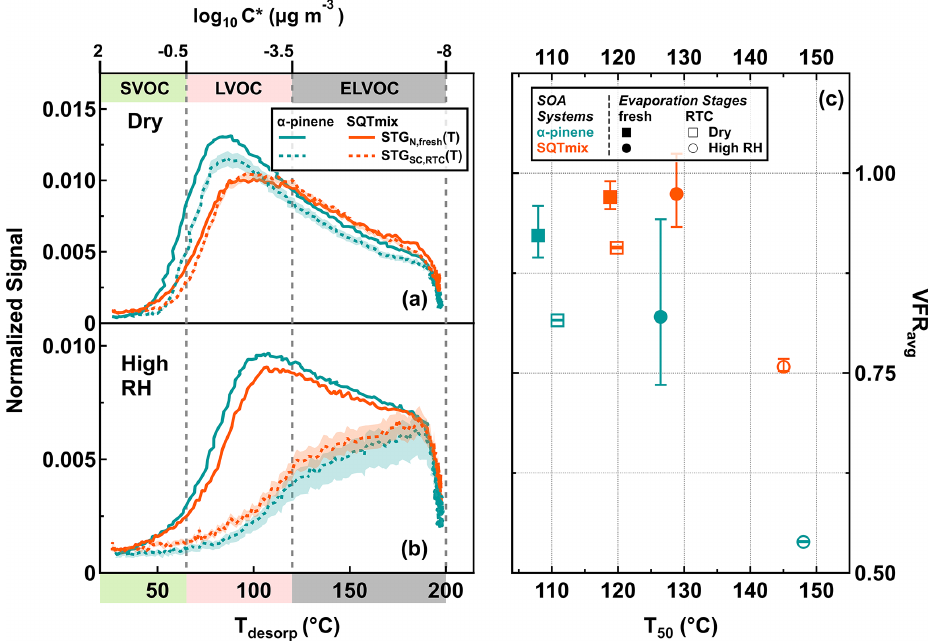
Figure 2. Sum thermograms (STGs) (a, b) , average volume fraction remaining (VFR avg ) (c) , and median desorption temperature ( T 50 ) (c) for α -pinene (turquoise) and SQTmix (orange) SOA particles, for dry (RH < 7%; a ) and high-RH (RH 80%; b ) conditions. Shaded areas indicate the ranges of STG( T ) for RTC stages after accounting for changes and uncertainties in average molecular weight and particle density (i.e., α MW and β ρ in Eq. 2). Volatility classes (a, b) are derived from T max – C ∗ calibrations using a set of PEG compounds (Ylisirniö et avg avg al., 2021). They are indicated by different color bands on the abscissa using the classification according to Donahue et al.